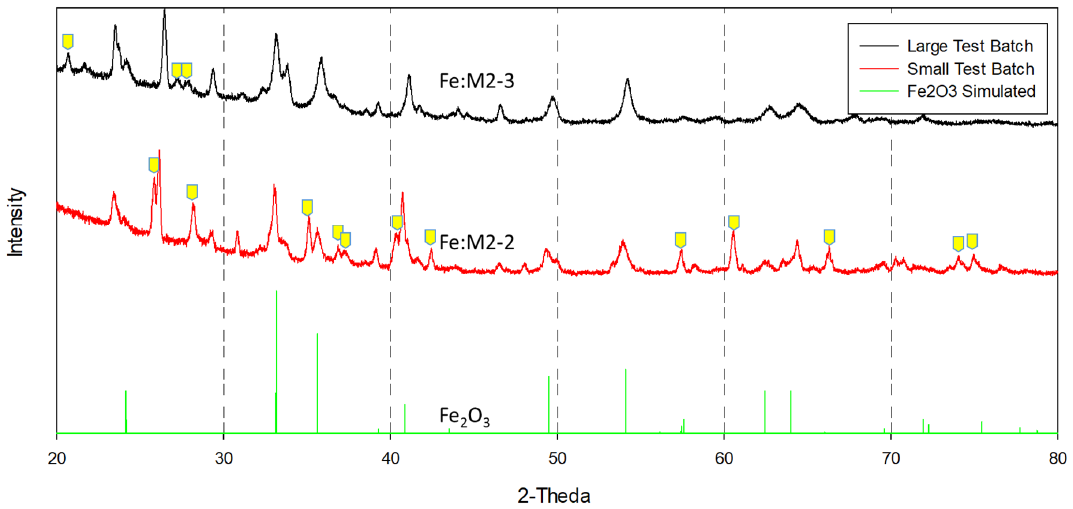
Figure 5. X-ray diffraction analysis of commercially prepared catalyst formulations, large test batch (Fe:M2-3), and small test batch (Fe:M2-2).